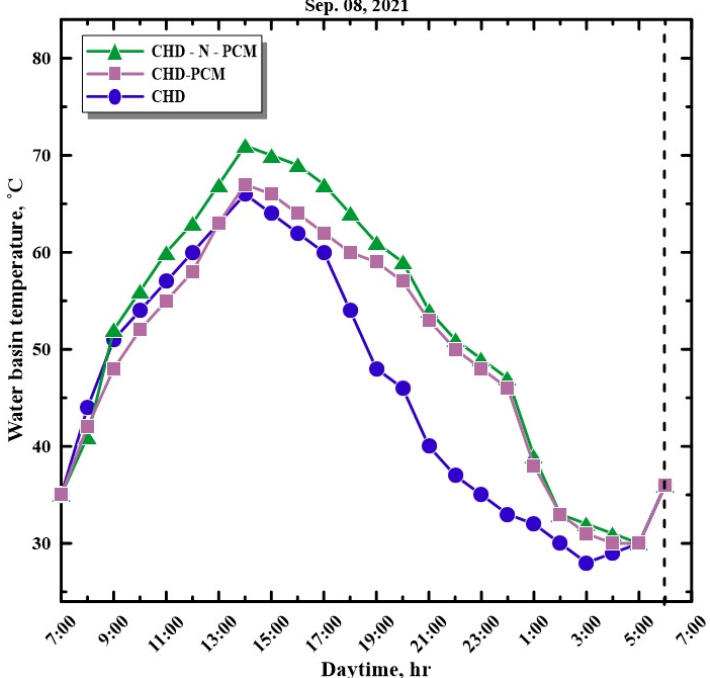
Figure 7. Hourly variation in water basin temperature with time.